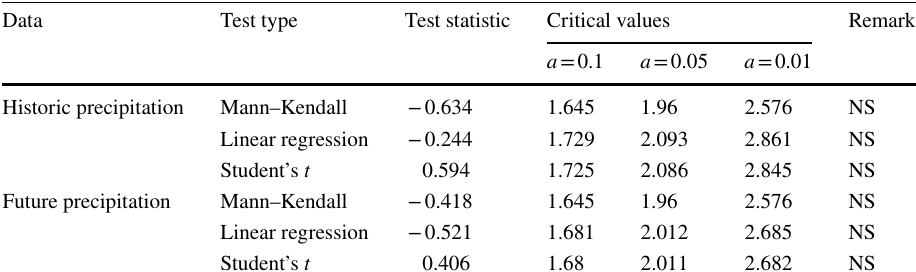
Table 3 Gp112221 station historical and future temperature data trend